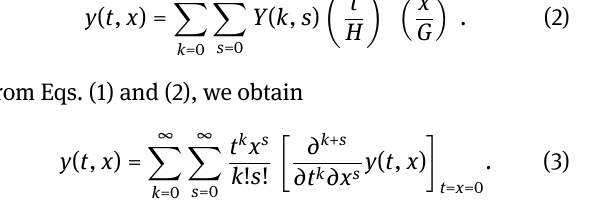
Fig. 1. Analytical model for a finite-thickness slab subjected to hy- grothermal